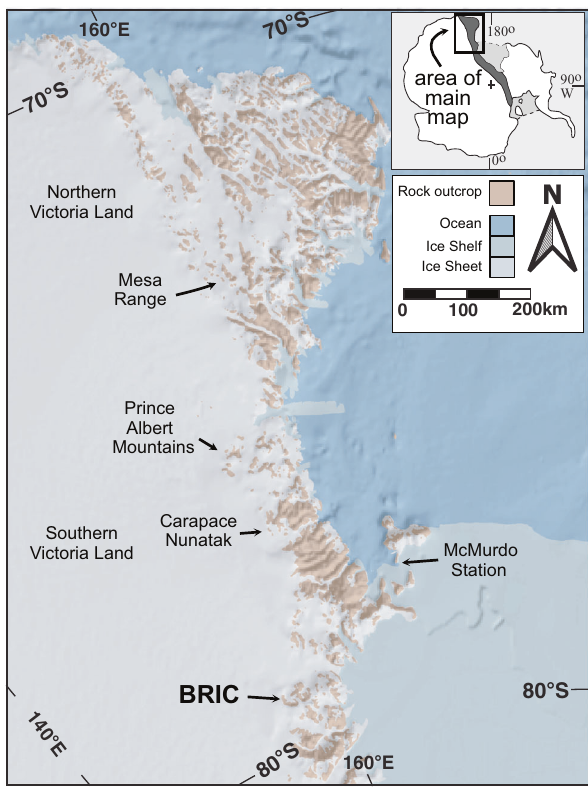
Fig. 1 | Location of Butcher Ridge Igneous Complex. Bedrock map of Northern and Southern Victoria Land, Antarctica, showing the distribution of outcrop and locationoftheButcherRidgeIgneousComplex(BRIC)andotherlocalitiesreferred to in the text with demonstrated mid to late-Cretaceous alteration ages. Basemap constructedusingQuantarcticav3.2fromtheNorwegianPolarInstitute(Matsuoka, K. et al. Quantarctica, an integrated mapping environment for Antarctica, the Southern Ocean, and sub-Antarctic islands. Environmental Modeling and Software 140, 105015 (2021)) with Rock outcrop data from SCAR Antarctic Digital Database (ADD) Version